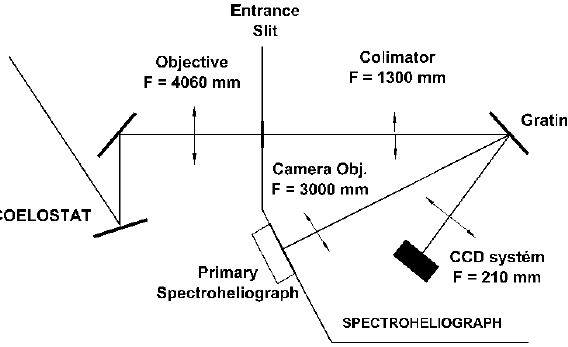
Figure 7. Optical system of the COI spectroheliograph [Source: Klvaňa et al.